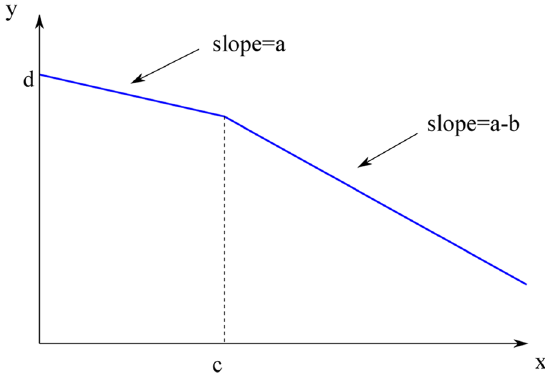
Figure 5. Graph of a two-segment piecewise function.